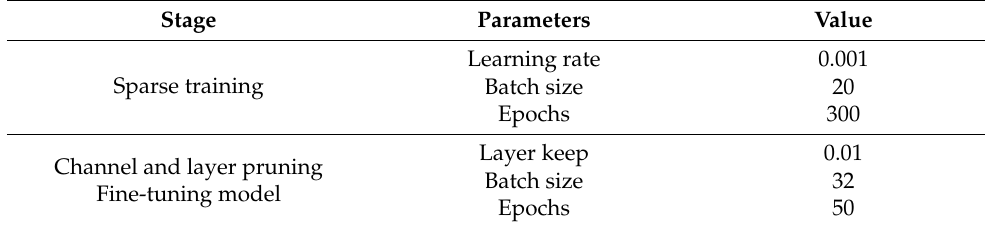
Table 2. Parameter settings for the YOLOv3-SPP3 pruning.